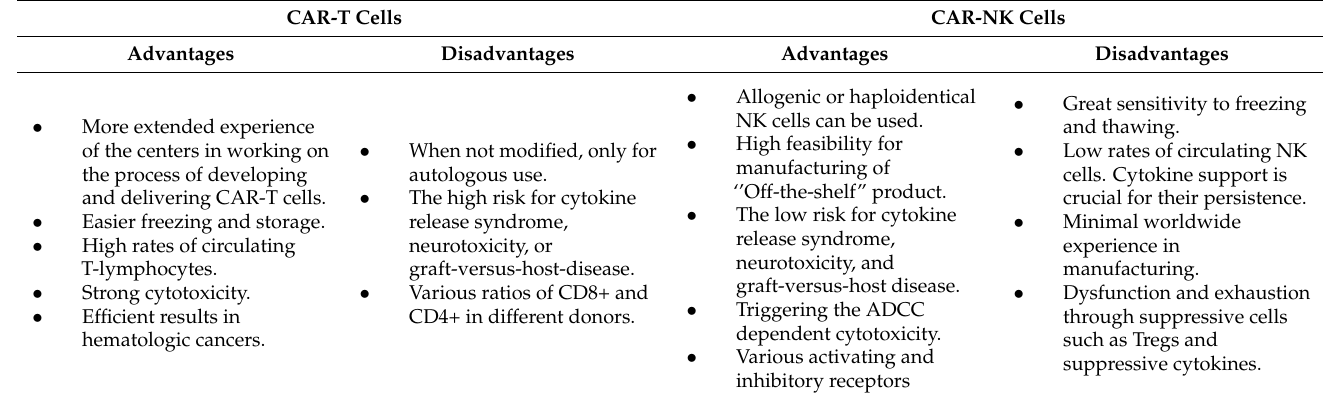
Table 4. Advantages and disadvantages of CAR-T [58] and CAR-NK cells